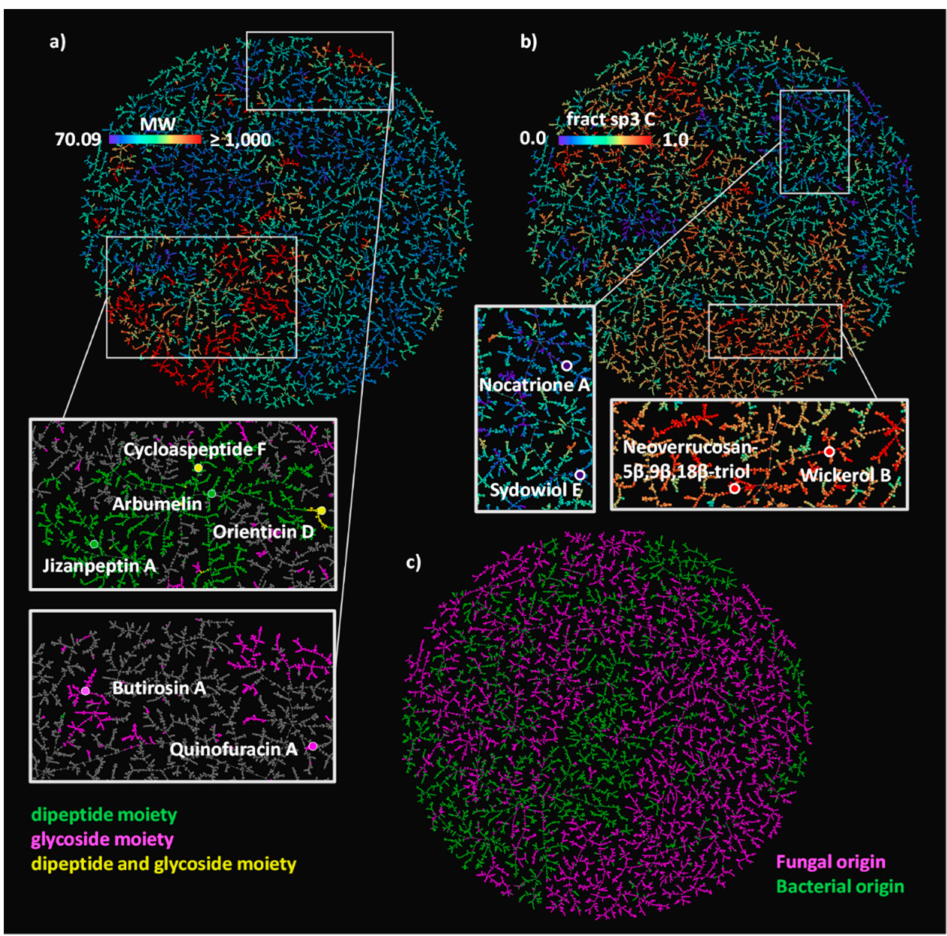
Figure 1. ( A ) NPAtlas MAP4 TMAP colored by MW, with a rainbow scale where the lowest values are purple, and the highest values are red. Two areas of the map are zoomed and colored by SMARTS substructure match: compounds containing a dipeptide moiety are highlighted in green, compounds containing a glycoside moiety are highlighted in magenta, compounds containing both moieties are highlighted in yellow; six examples of NPAtlas entries are reported with the same color code. ( B ) The NPAtlas MAP4 TMAP colored by fsp3C with a rainbow scale where the lowest values are purple, and the highest values are red. A low and a high fsp3C area of the map are zoomed, and two examples of polyphenols and of terpenoids are reported. ( C ) The NPAtlas MAP4 TMAP colored by a microbial origin classification, the compounds originated from fungi are colored in magenta, the compounds produced by bacteria are colored in